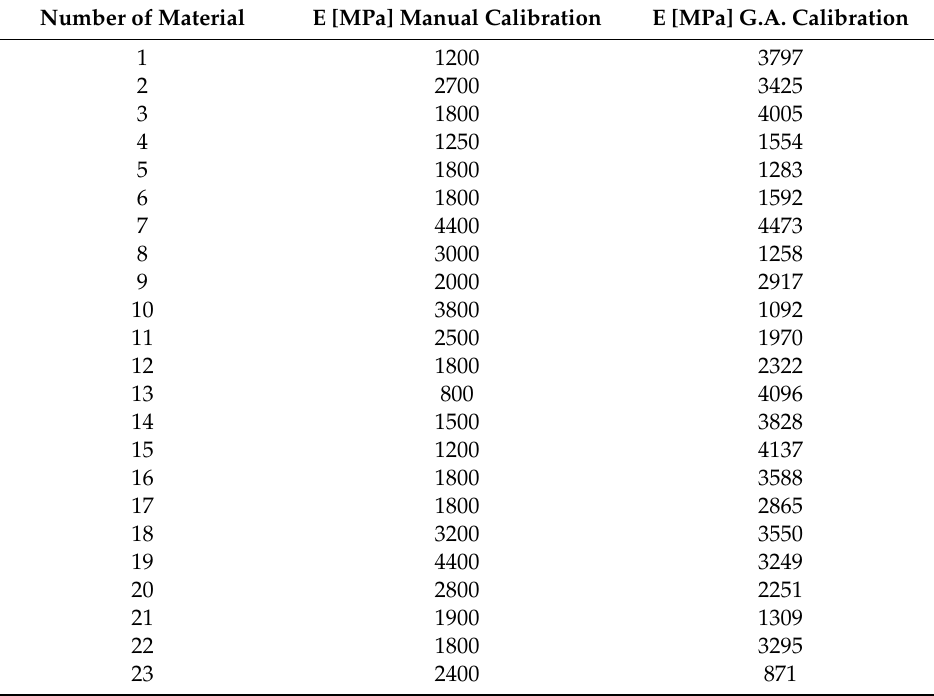
Table 7. Young’s Modulus values (E, MPa). Di ff erences between the manual calibration and the G.A. calibration for the step